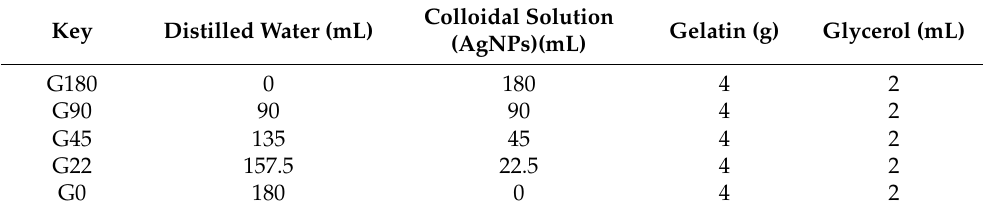
Table 1. The composition used in the preparation of gelatin